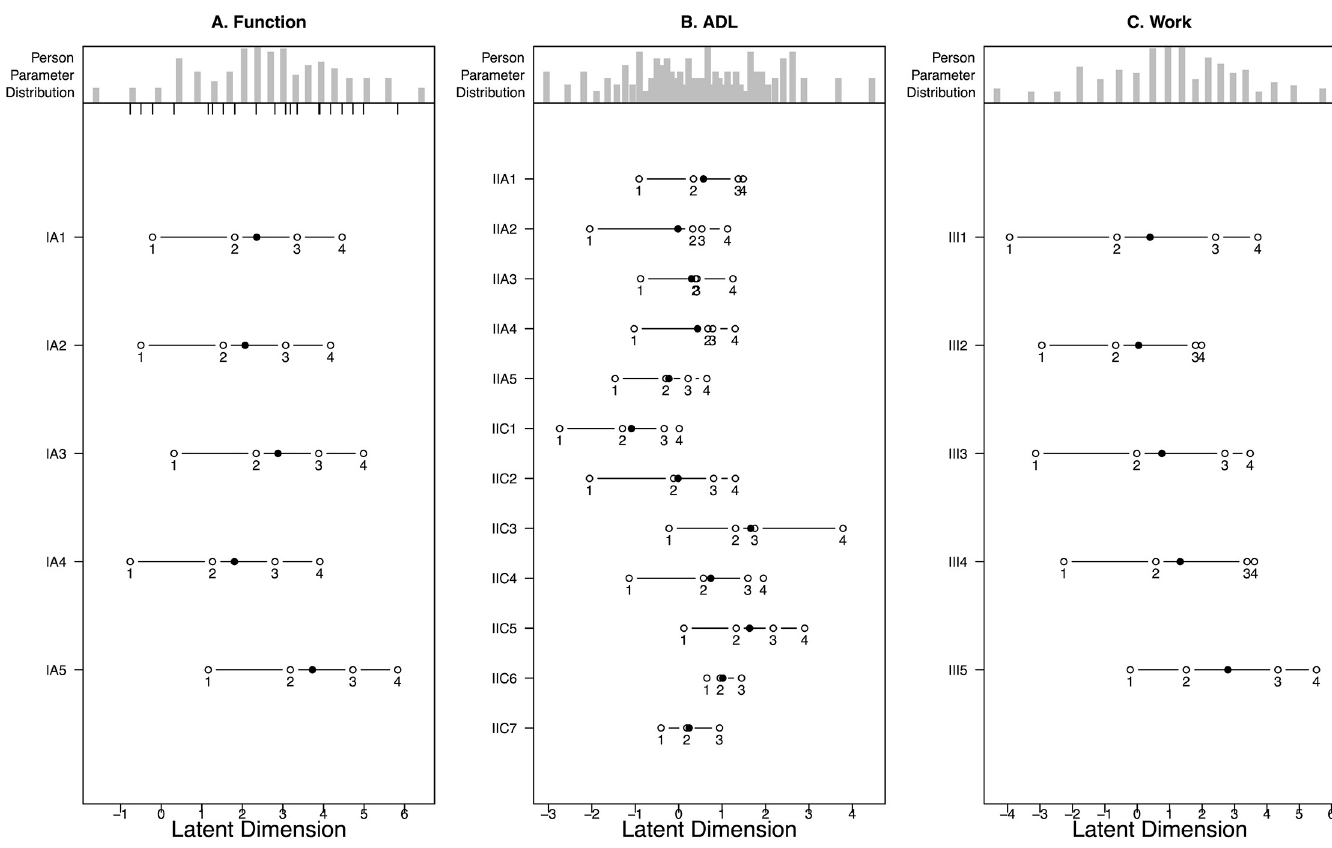
Fig 1. Person-Item Map and Threshold Ordering for Function (1a, left), ADLs after collapsing disordered thresholds (1b, middle), and Work (1c, right).